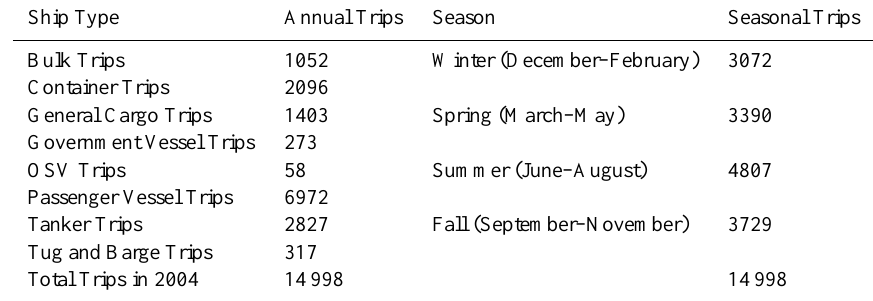
Table 1. 2004 Ship traffic by type and season reported by the Arctic marine shipping assessment (Arctic Council,